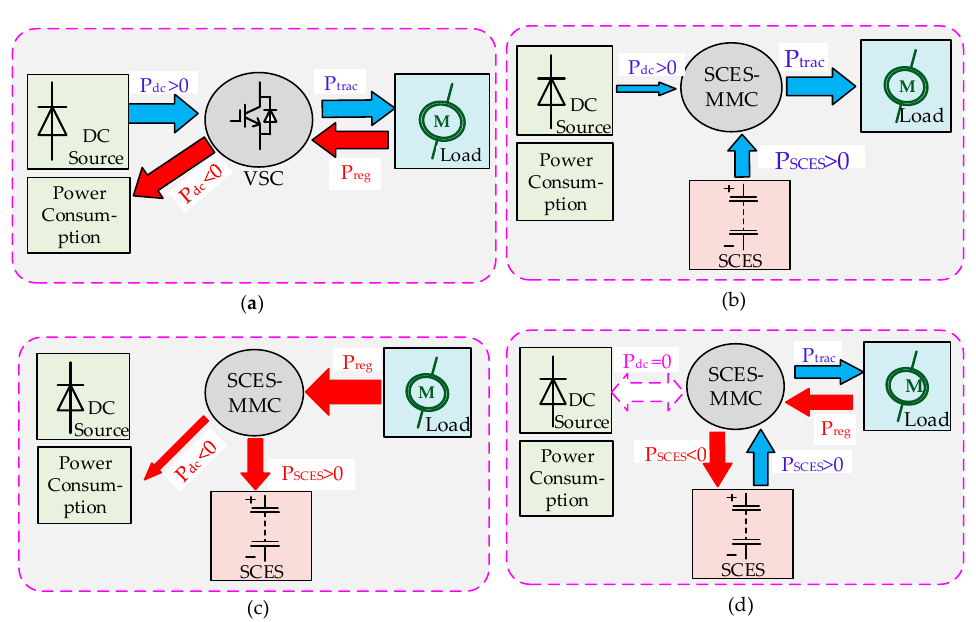
Figure 3. Illustration of power flow: ( a ) Conventional VSC without SCES; ( b ) Traction (discharging) condition; ( c ) Regeneration (charging) condition; ( d ) Fault operation mode.